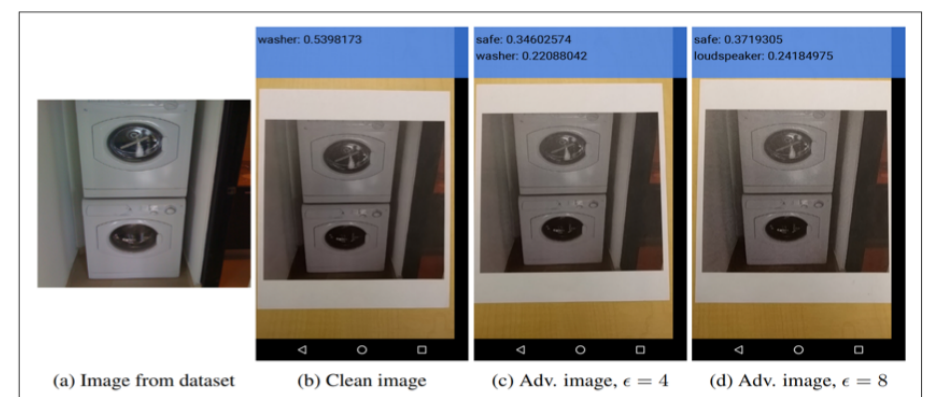
Figure 10. Demonstration of a black-box attack on a phone app for image classification using physical adversarial examples (Image Credit: Akhtar et al. [80]).